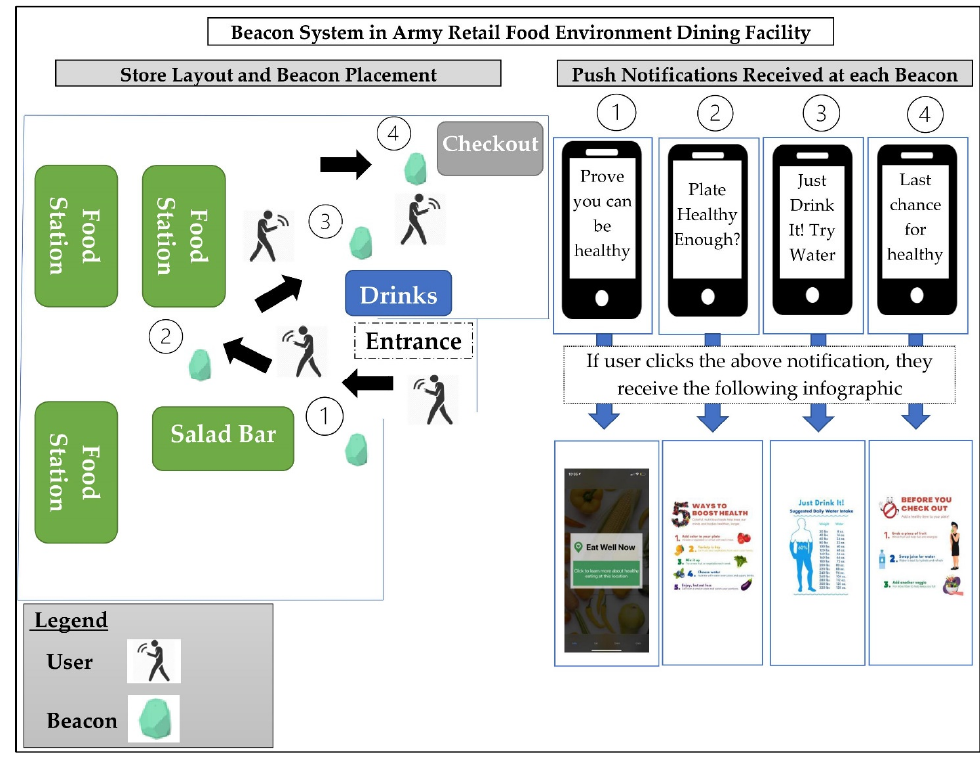
Figure 1. Map of the Bluetooth beacon setup within the food shopping environment and the corre- sponding messages and infographics one would see at each beacon location.